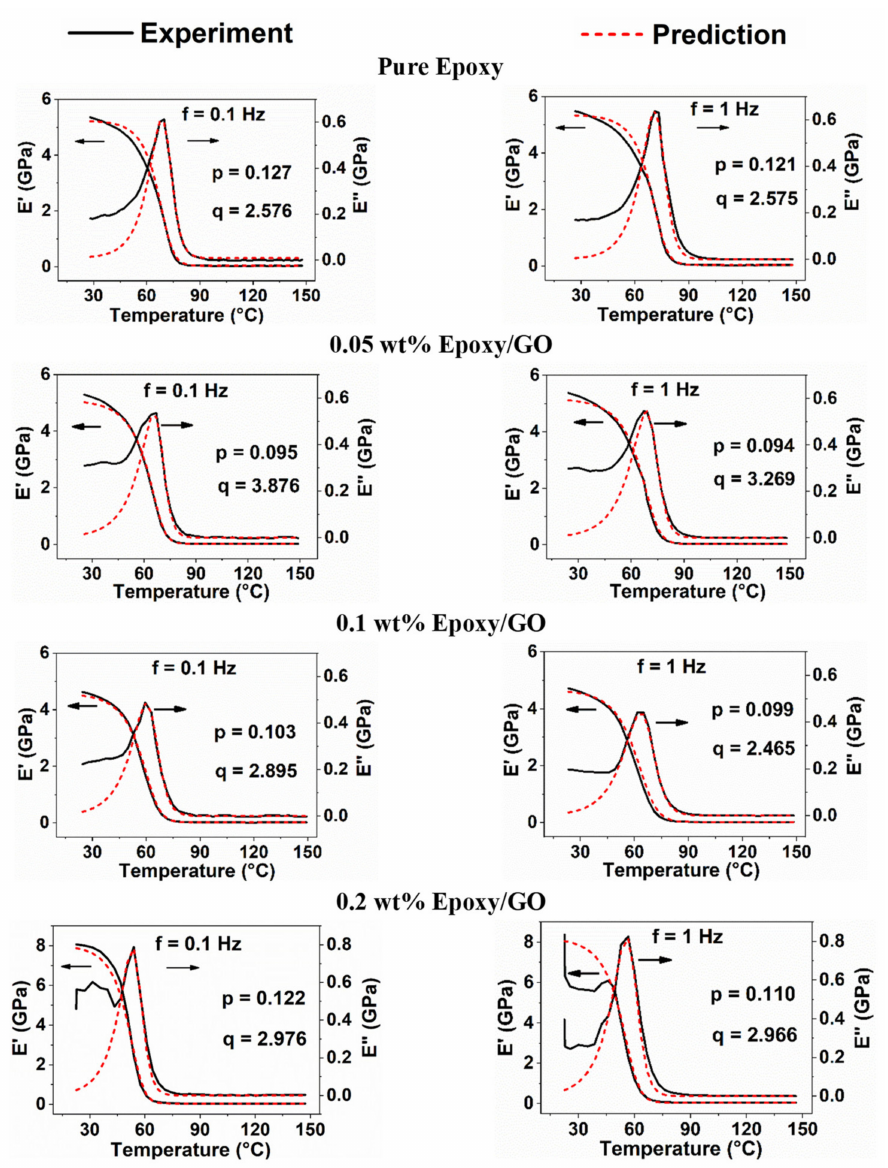
Figure 7. Comparison between experimental and predicted storage and loss moduli of pristine epoxy and GO samples at different